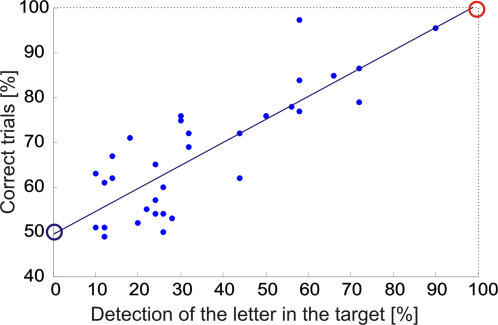
Correlation between the percentage of correct trials and percentage of detection of the letter in the target.Each dot represents data from one subject for one display duration. Note that the left extremity of the regression line (blue circle) corresponds to 50% correct responses in the CVS task and 0% of letter detection in the target and that the right extremity (red circle) corresponds to 100% correct response in the CVS task and 100% of letter detection in the target.